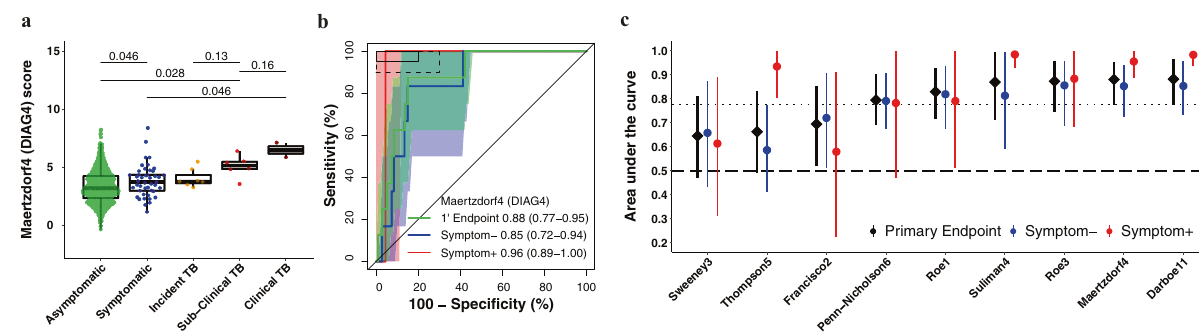
Fig. 3 Parsimonious signature diagnostic performance for prevalent TB and signature score distributions in people living with HIV. Representative ( a ) box-and-whisker plot and ( b ) receiver operating characteristic (ROC) curve of the parsimonious signature with the best diagnostic performance (Maertzdorf4/DIAG4 signature) in the CORTIS-HR study of people living with HIV. Box-and-whisker plots and ROC curves for the other signatures are in the Supplementary Information (Fig. S4). The box-and-whisker plot depicts Maertzdorf4 (DIAG4) signature score (measured at enrolment) distribution by symptom status (each dot represents a participant) in asymptomatic ( n = 743) and symptomatic ( n = 45) participants with no TB, participants who progressed to incident TB ( n = 7), and participants with prevalent subclinical (asymptomatic; n = 6) and clinical (symptomatic; n = 2) TB. Prevalent and incident TB comprised all primary endpoint cases. Symptoms were recorded at the time of enrolment for participants without TB and those with prevalent TB. p-values for comparison of median signature scores between groups in the box-and-whisker plot were calculated with the Mann – Whitney U test and corrected for multiple comparisons by use of the Benjamini – Hochberg Procedure 39 . Boxes depict the IQR, the midline represents the median, and the whiskers indicate the IQR ± (1.5 × IQR). The ROC curve depicts diagnostic performance (area under the curve, AUC, with 95% CI) of the Maertzdorf4 (DIAG4) parsimonious signature for TB diagnosed for the primary endpoint (1 ’ Endpoint), i.e. TB diagnosed on two or more liquid culture-positive or Xpert MTB/RIF-positive sputum samples. The ROC curves show participants with symptomatic clinical prevalent TB versus symptomatic controls (Symptom + ), and participants with asymptomatic subclinical prevalent TB versus asymptomatic controls (Symptom – ). The shaded areas represent the 95% CIs. The solid box depicts the optimal criteria (95% sensitivity and 80% speci fi city) and the dashed box depicts the minimal criteria (90% sensitivity and 70% speci fi city) set out in the WHO Target Product Pro fi le for a triage test 20 . c Summary of signature diagnostic performance in order of primary endpoint AUC estimates. The diagnostic AUC estimates in symptomatic and asymptomatic participant sub-groups are also shown. The midline indicates the AUC estimate, the error bars indicate the 95% CIs, and the black dotted line indicates the lower bound of the 95% CI for the best performing signature for the primary endpoint. The black dashed line indicates an AUC cut-off of